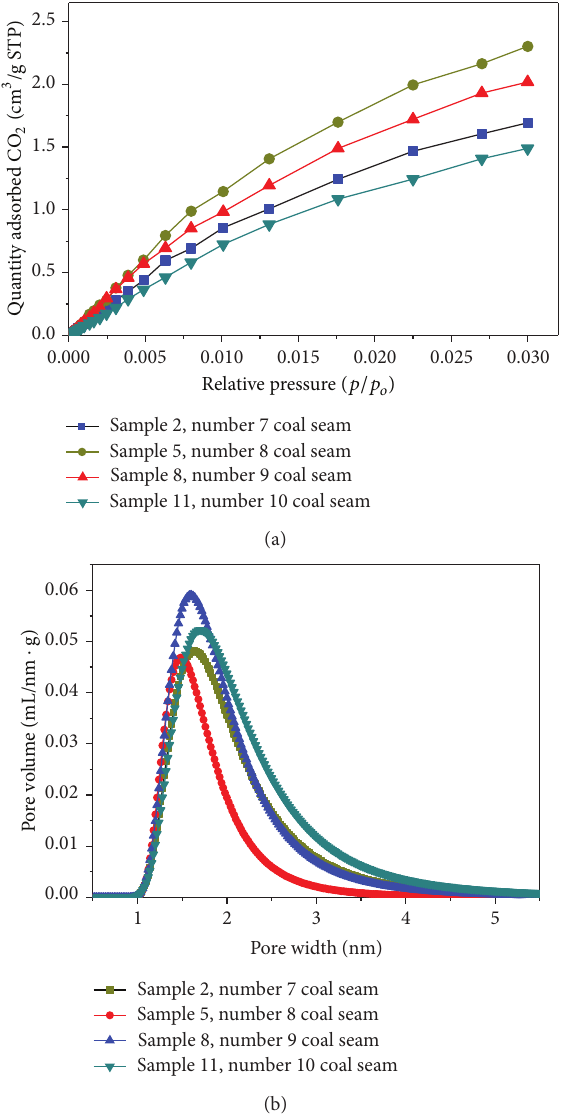
Figure 8: Quantities of carbon dioxide adsorbed onto coals at relative pressure (a) and microspore size distribution as determined by the DA method (b).